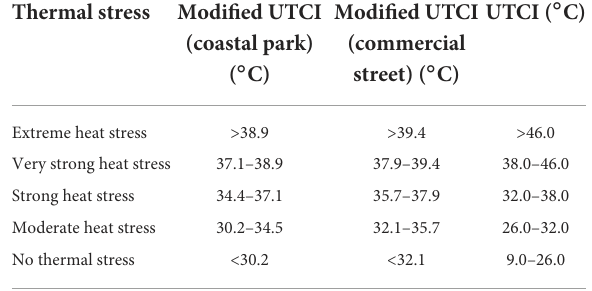
and needs in different spaces (Figure 9). The respondents